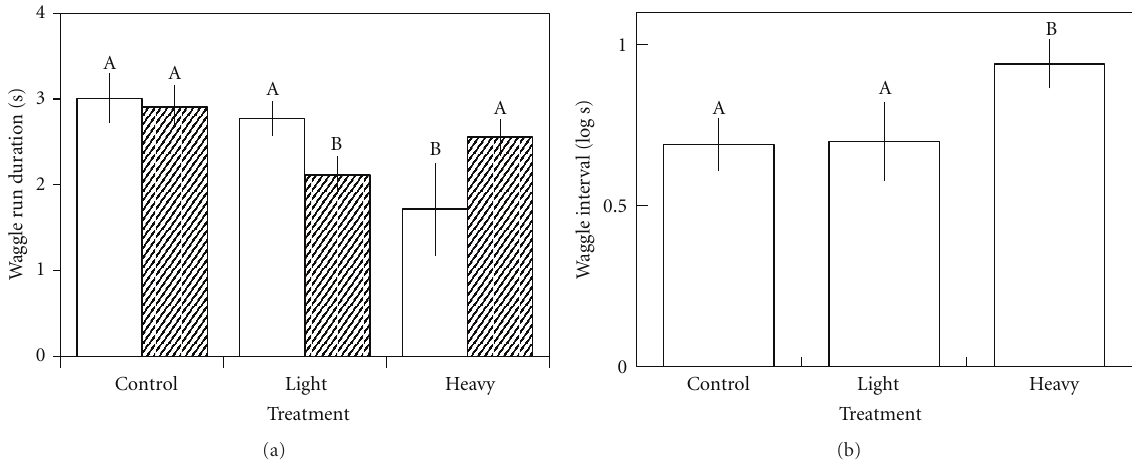
Figure 4: (a) Mean (+ 1 SE) duration of waggle run per dance for each treatment group and whether they were damaged after they started foraging (open bars) or at eclosion (hatched bars). (b) Mean ( ± 1 SE) interval between waggle runs per dance ( return run ) for the three treatment groups. Bars that share the same letter did not significantly di ff er. Heavy bees indicated lower quality nectar sources than Control and Light